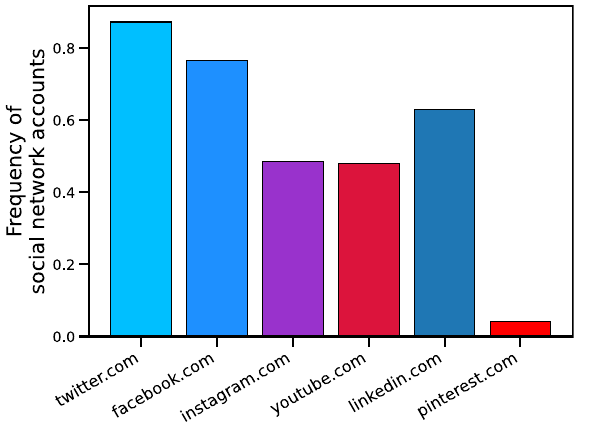
Figure 1. Online social networks adoption among large firms in the UK. Twitter is the most popular online social network for large firms in the UK, overcoming the other ones.